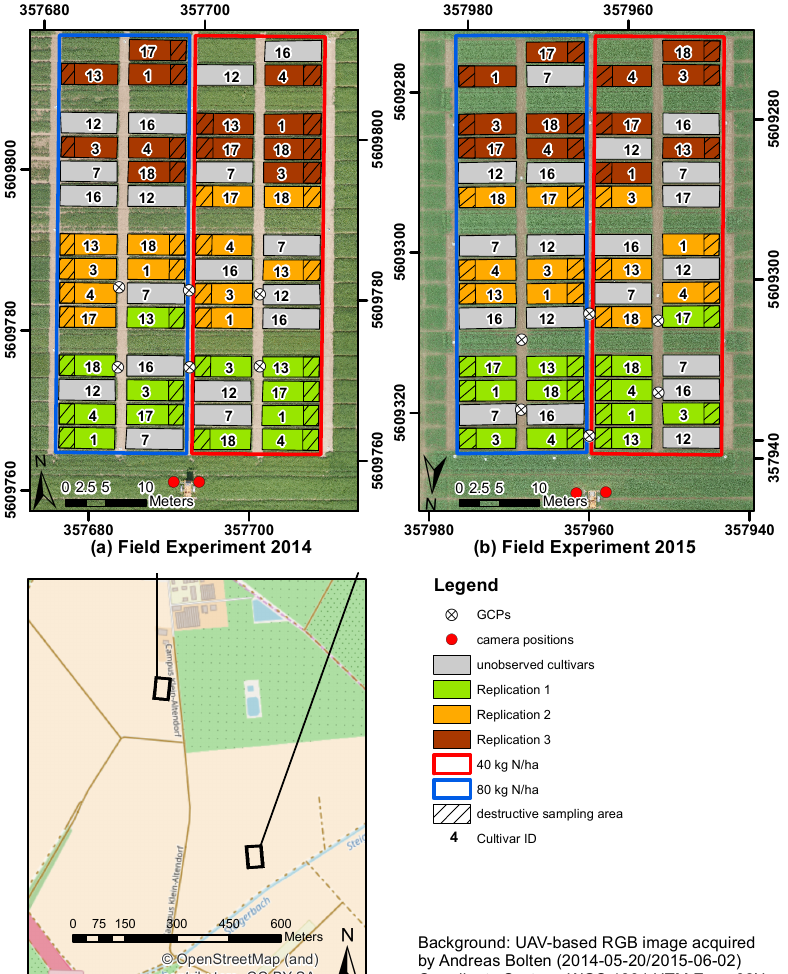
Figure 1. Summer barley field experiment in 2014 and